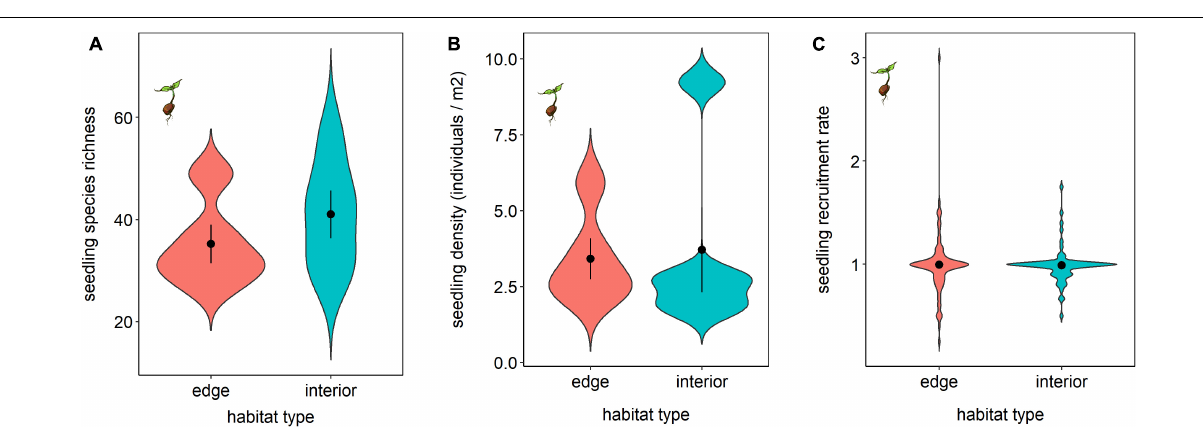
FIGURE 3 | Species richness (A) and density (B) of seedlings as well as rates of seedling recruitment after 21 months (C) , for the zoochoric species that were captured in seed traps, in forest edge and interior